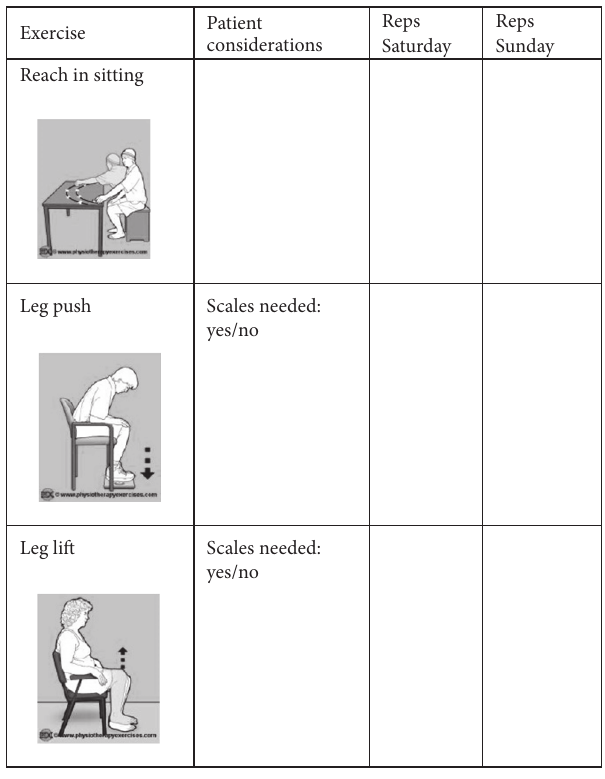
Figure 2: Images copied with permissionof http://www.physiother- apyexercises.com, a freely available website for exercise